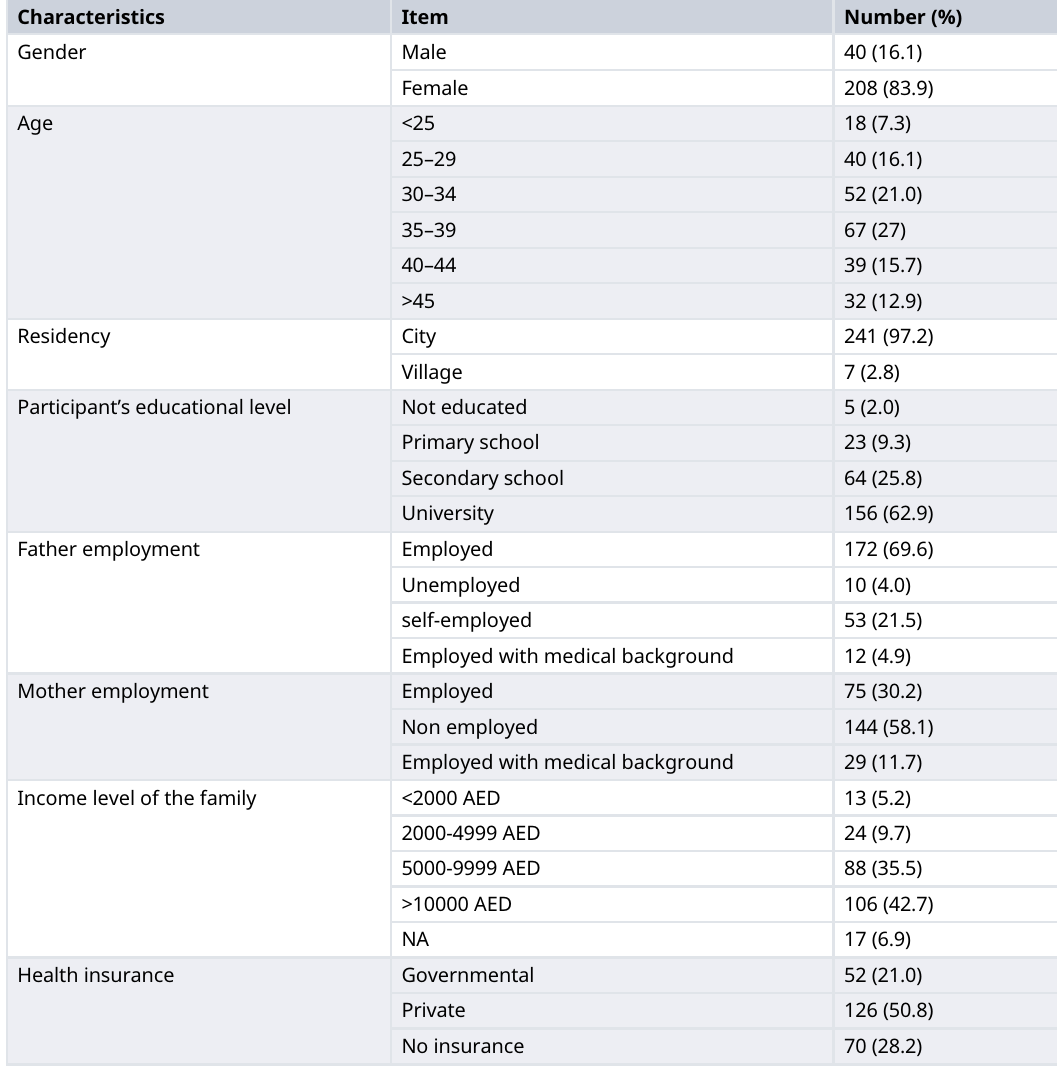
Table 1. Demographic information of parents (N =